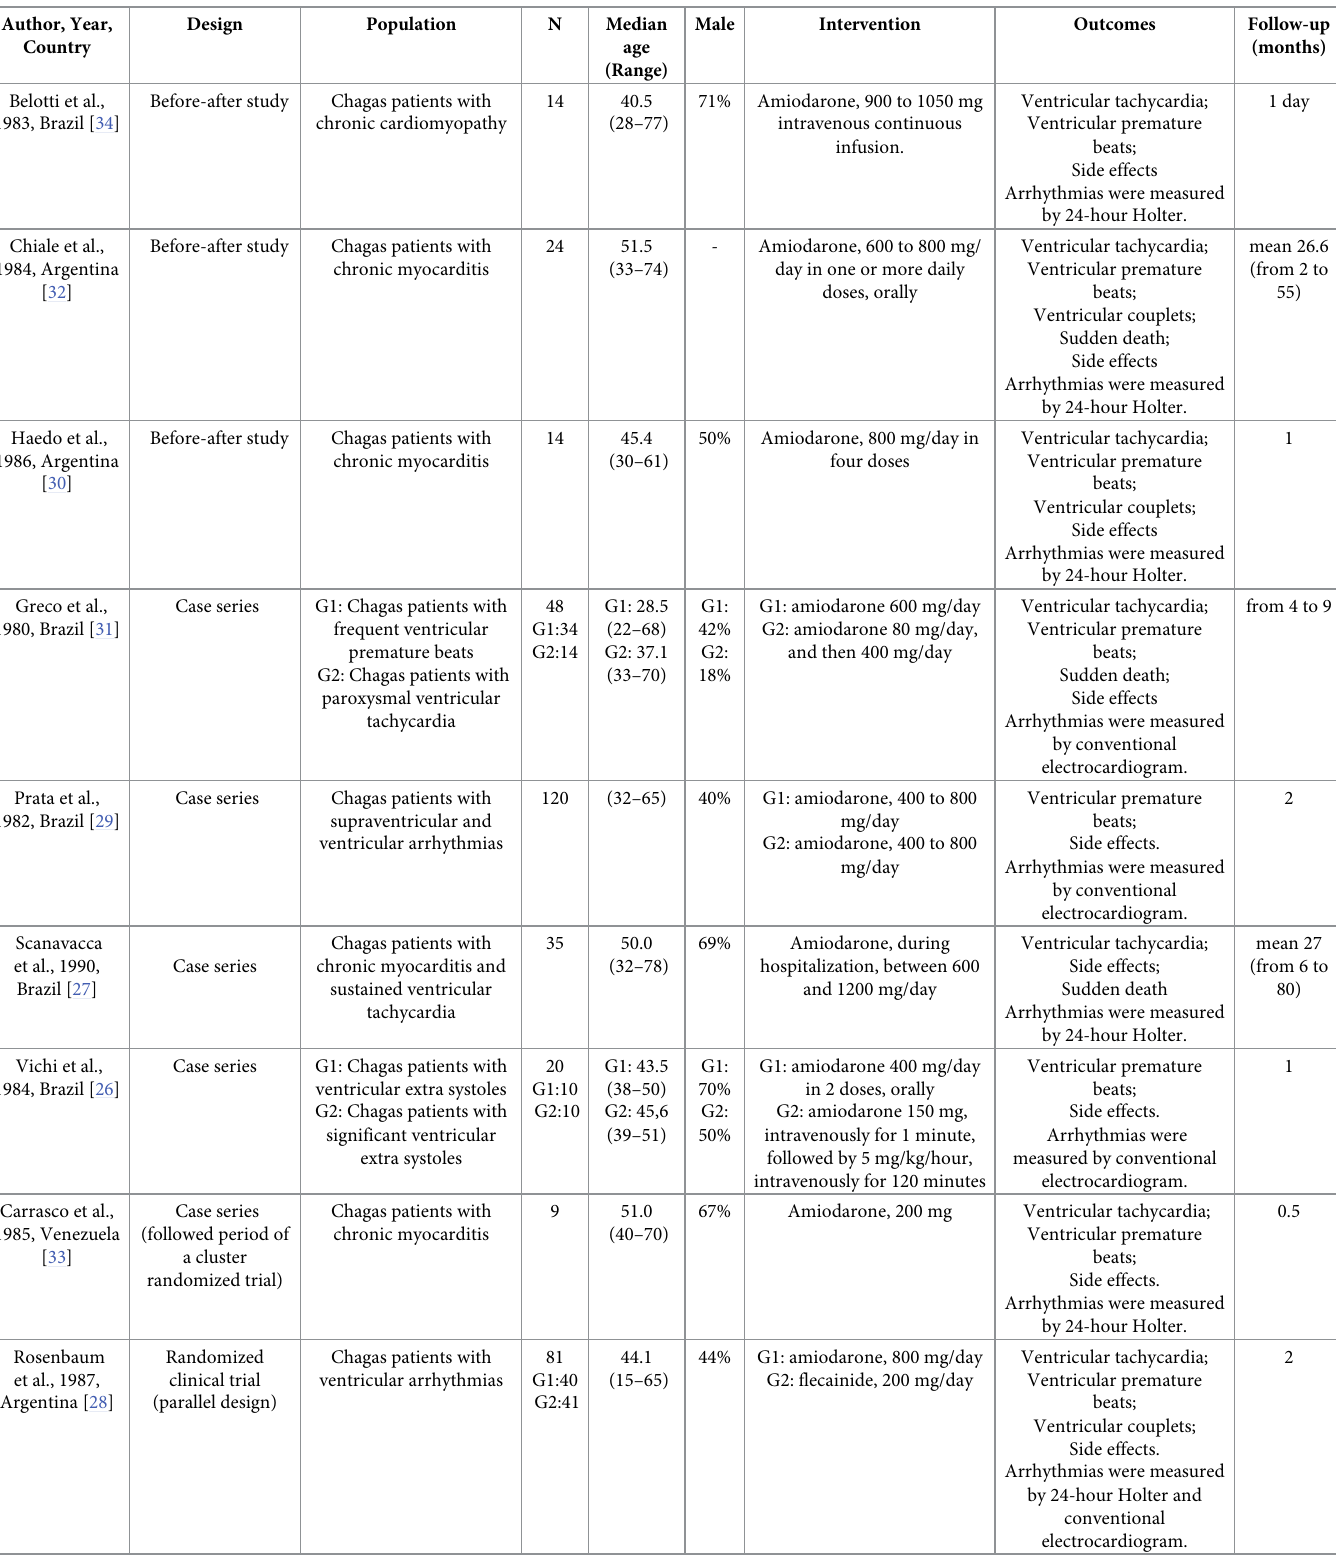
Table 1. Characteristics of studies included in systematic